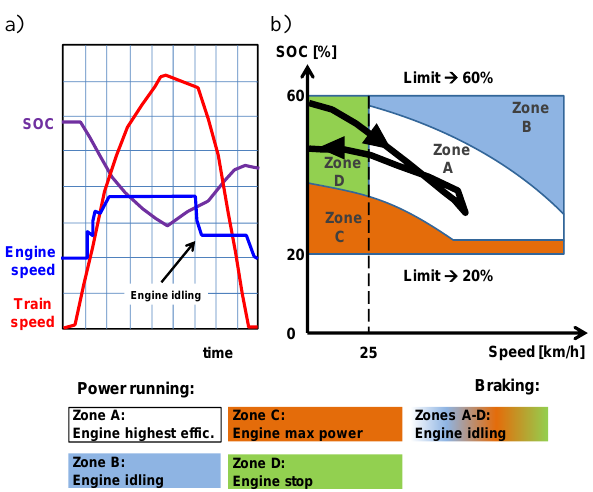
Fig. 15. Example of a hybrid drive system control: a) route, b) hybrid control zones, taking into account the battery charge level [8] results in a constant rotational speed of the internal combus- tion engine and further discharge of the batteries (parallel